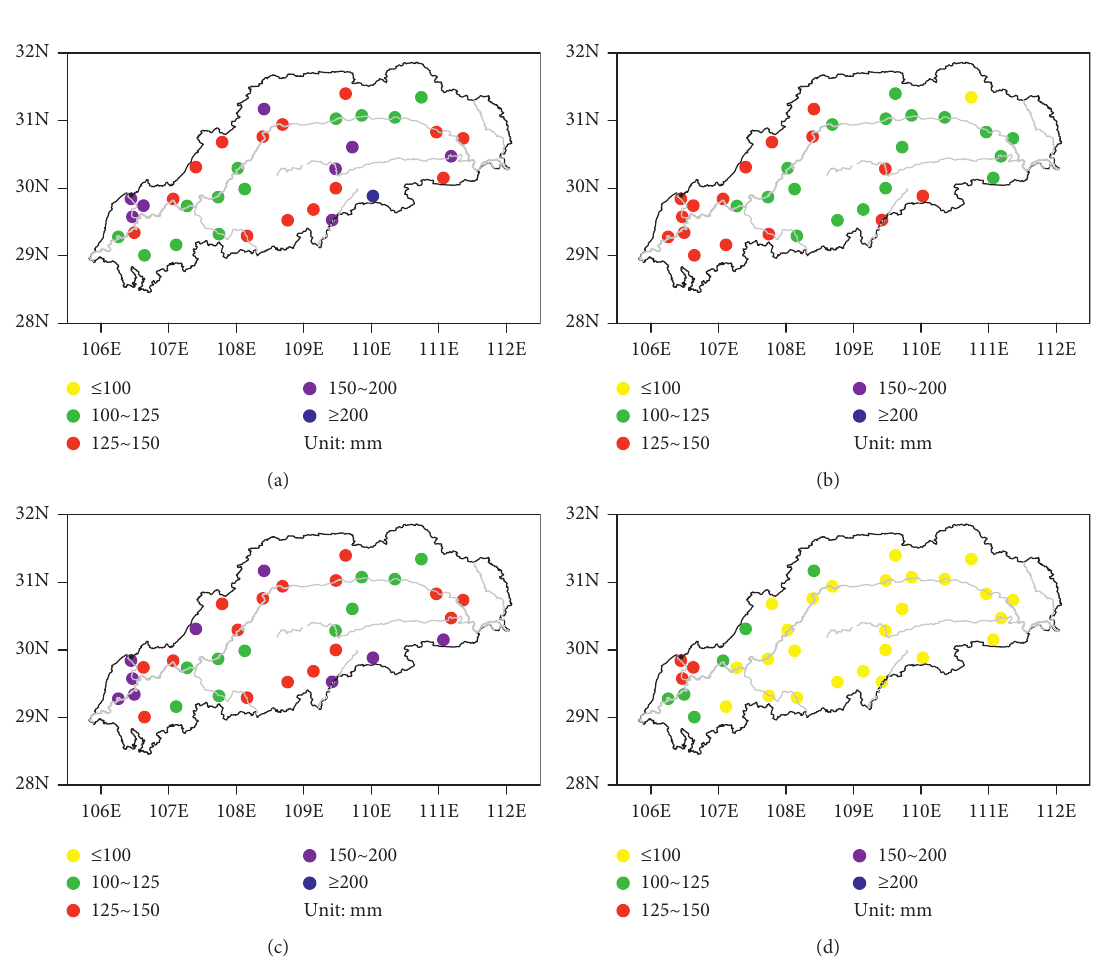
Figure 20: The spatial distribution of RX5day calculated from (a) gauge observation, (b) TRMM, (c) CMORPH, and (d) PERSIANN at each rain-gauge